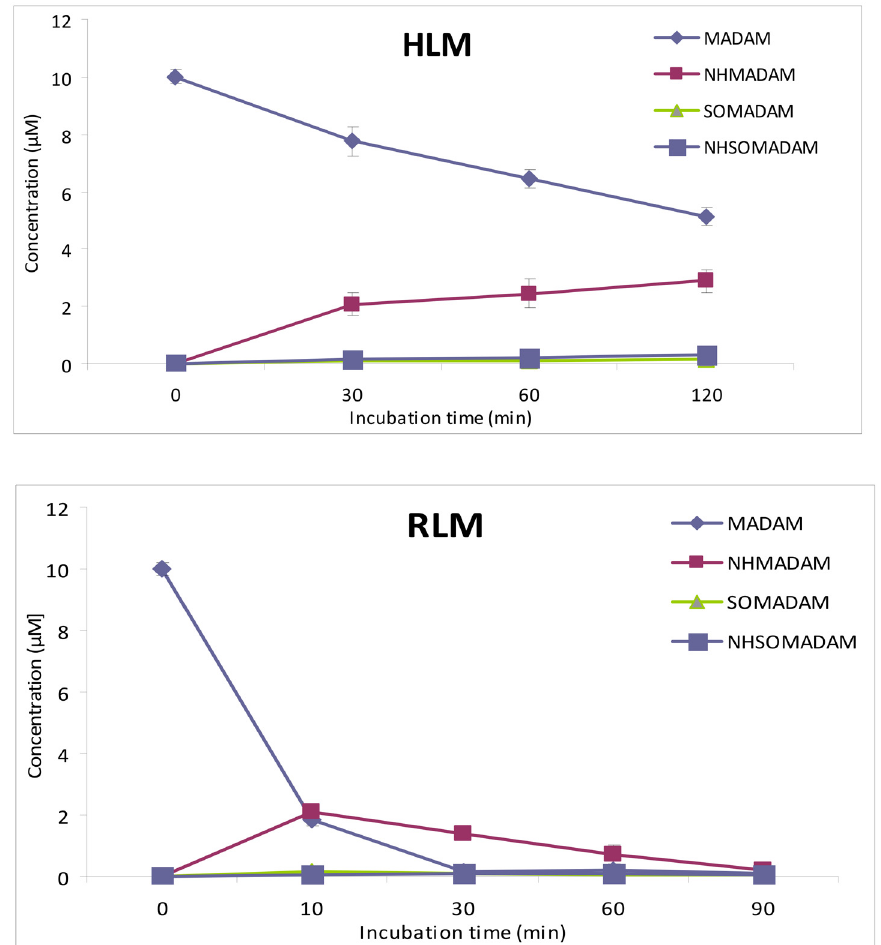
Fig 5. Concentrations of MADAM, NHMADAM, SOMADAM, NHSOMADAM produced by HLM and RLM at various incubation times.